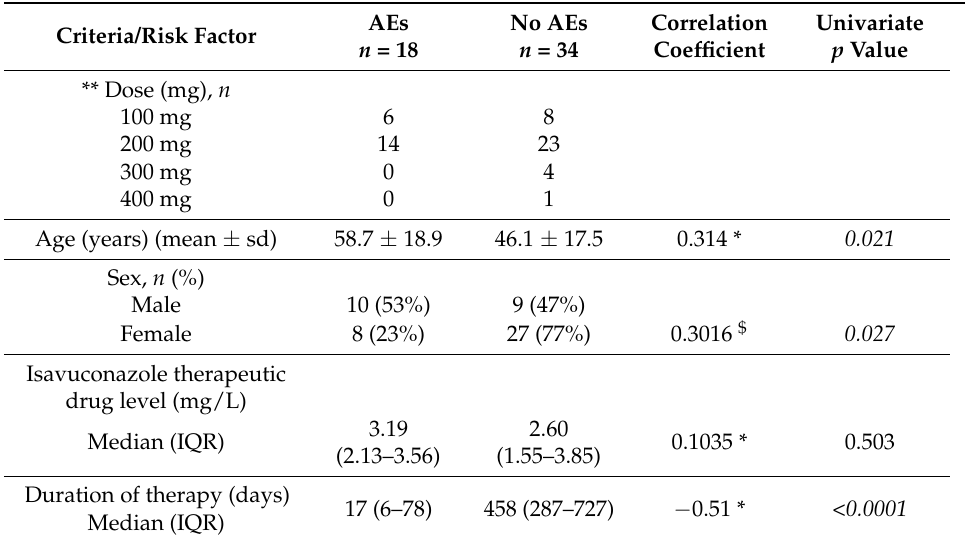
Table 3. Criteria/risk factors for developing adverse effects on isavuconazole